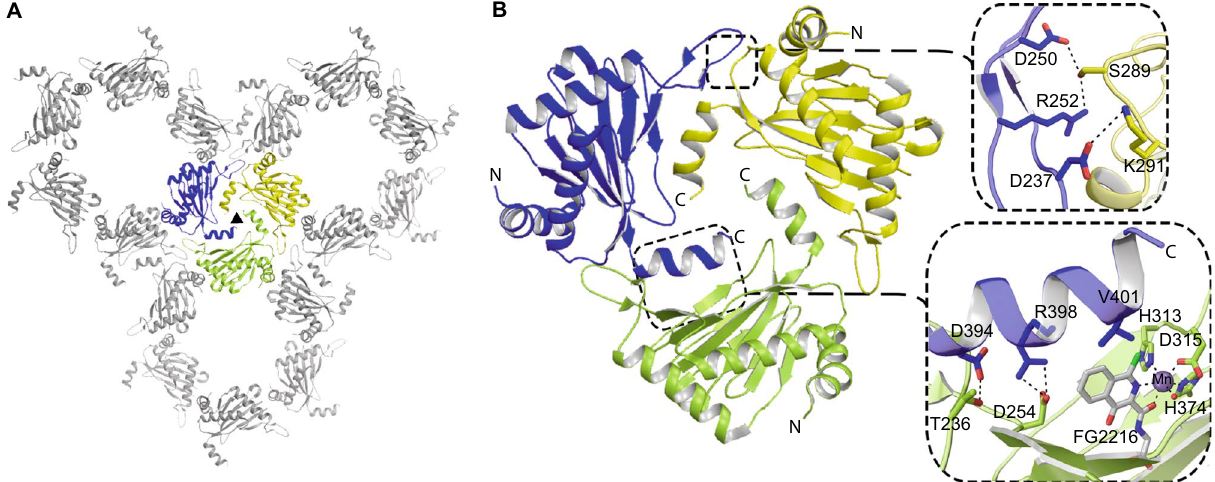
Figure 1. PHD2 crystallizes as a homotrimer with bicyclic ligands. ( A ) The homotrimeric crystal packing observed in the nPHD2/ P 6 3 crystal structure (PDB ID: 4BQX). ( B ) The PHD2 homotrimer is stabilised by intermolecular interactions between the active site residues including from the N -terminal β2/β3 loop (aa 237–254) and the C -terminal helix α4 (aa 393–402) of a threefold symmetry related molecule. The overall PHD2 (aa 188–404) fold consists of the major (β1, β8, β5, β10, β4) and minor (β7, β6, β9, β-II) β-sheets of the DSBH, and four α helices. Both the β2/β3 ‘finger’ loop and the C -terminal helix α4 of the PHDs directly interact with the HIF-α ODDs (see Fig.